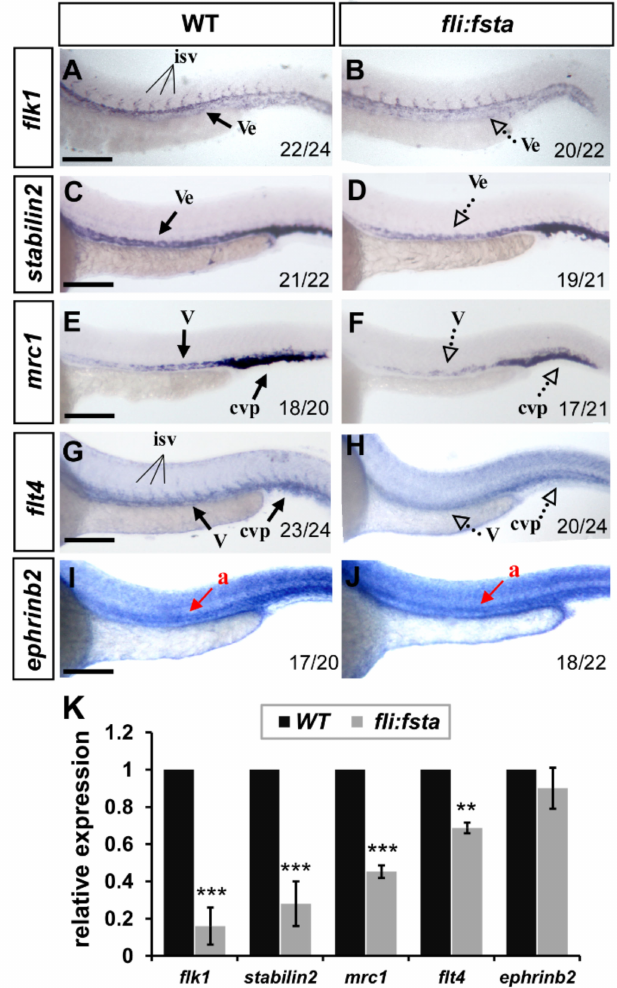
Figure 5. fli, driving fsta -overexpressing (fli:fsta) fish, remodeled the expression of vascular mark- ers. ( A – J ) When compared to wild type controls ( A , C , E , G , I ), the expression of the pan-vascular markers flk1 and stabilin2 at the vessels (ve) and caudal vein plexus (cvp) were decreased in (fli:fsta) - overexpressed fish at 24 hpf ( A – D ). In addition, the expression of venous markers mrc1 ( E , F ) and flt4 ( G , H ) were reduced in the posterior cardinal vein (v) and caudal vein plexus (cvp) in (fli:fsta) - overexpressed fish at 24 hpf. The expression of the arterial marker ephrinb2 ( I , J ) is not changed. Values on the bottom indicate the number of embryos exhibiting a phenotype per the total number of embryos analyzed. Scale bars represent 200 µ m in ( A – J ). ( K ) Quantification of the relative expression level by qPCR assay showed a ~50 to 80% reduced expression in the vascular markers flk1 (0.16 ± 0.1), stabilin2 (0.28 ± 0.12), mrc1 (0.45 ± 0.03), and flt4 (0.69 ± 0.03) in (fli:fsta) embryos; the expression of ephrinb2 (0.9 ± 0.11) in (fli:fsta) embryos is unchanged when compared to wild-type. qPCR data are presented as the mean ± S.D. *** Refers to p < 0.0001 and ** refers to p < 0.001 by an unpaired Student’s t